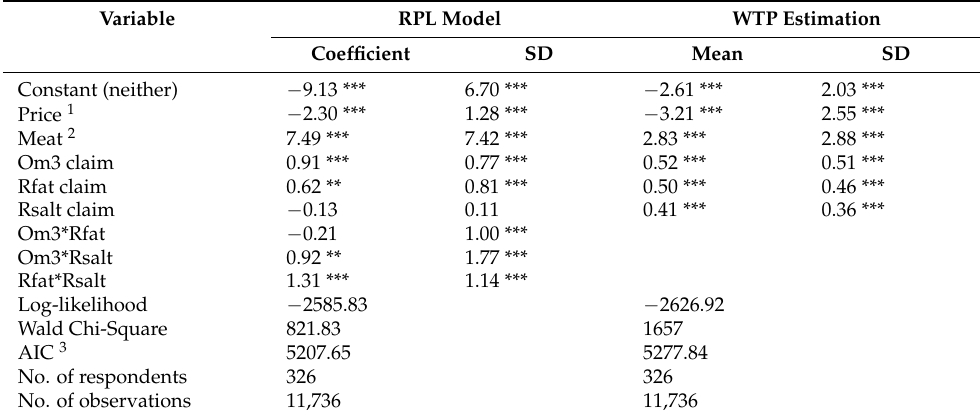
Table 3. Results of the RPL model and WTP